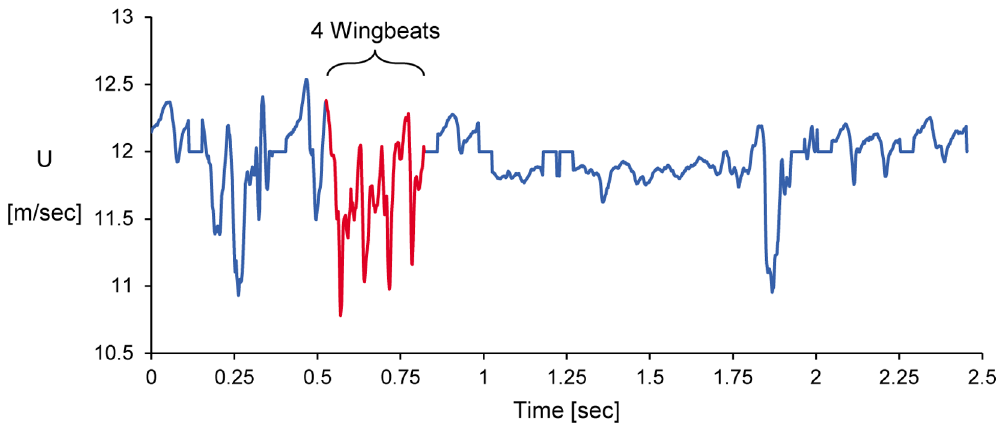
Figure 3. Variation of the average streamwise velocity in the wake with time.